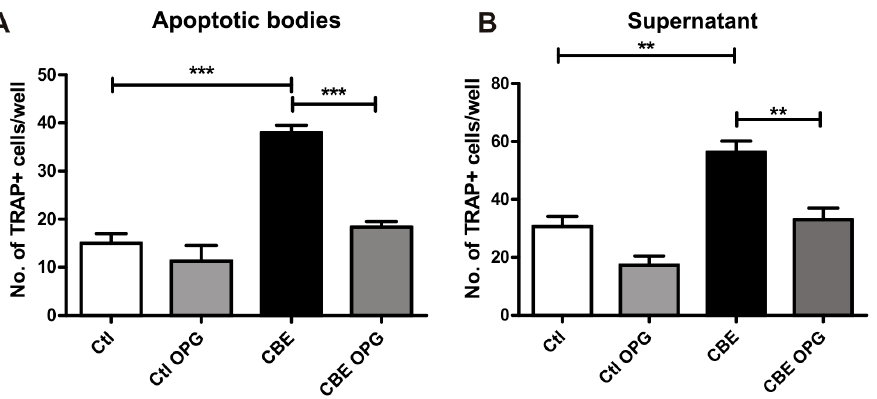
Figure 4. Osteoclast differentiation by conditioned media involves apoptotic bodies and receptor activator of nuclear factor κ -B ligand (RANKL). MLO-Y4 cells were treated with CBE for seven days and conditioned media were harvested and centrifuged to obtain apoptotic body and supernatant fractions. Osteoclast differentiation assays were performed in the presence of the fraction containing the apoptotic bodies ( A ) or the supernatant fraction ( B ). Experiments were carried out in the presence or absence of recombinant osteoprotegerin (OPG) to evaluate RANKL involvement. + cells with ≥ 3 nuclei were counted. Data are expressed as mean ± SD ( n = 5) and are representative of three independent experiments performed. ** p < 0.01 *** p < 0.001 one-way ANOVA.